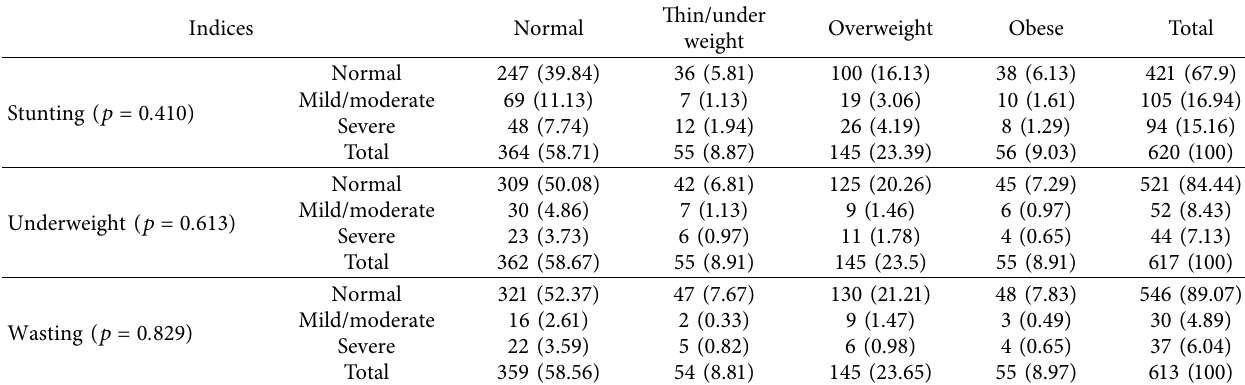
Table 4: Anthropometric categories of mothers with their children.